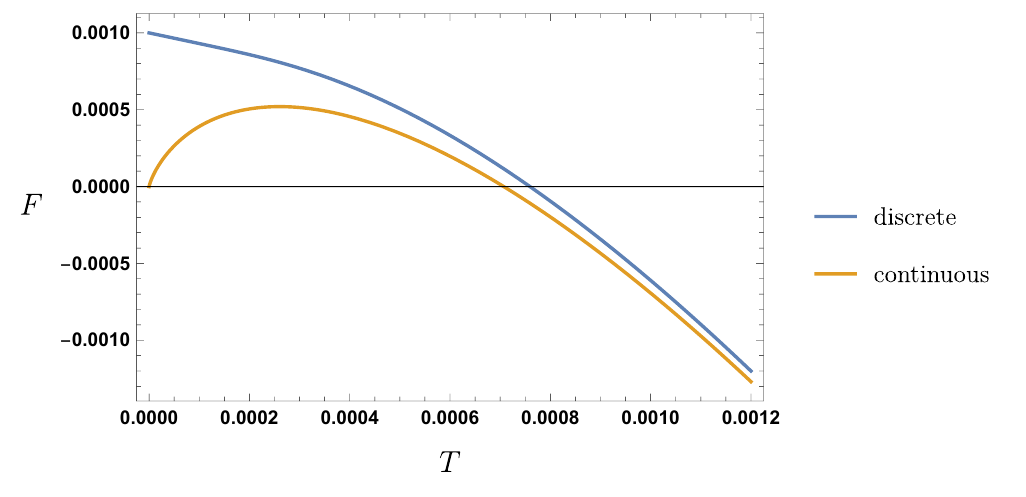
Figure 10 . Free energies of a discrete system and its continuous limit. We see that a non- monotonous free energy can arise when taking the continuous limit of a discrete system. The plot was made with e S 0 = 2 , Λ = 0 . 1 and L = 100